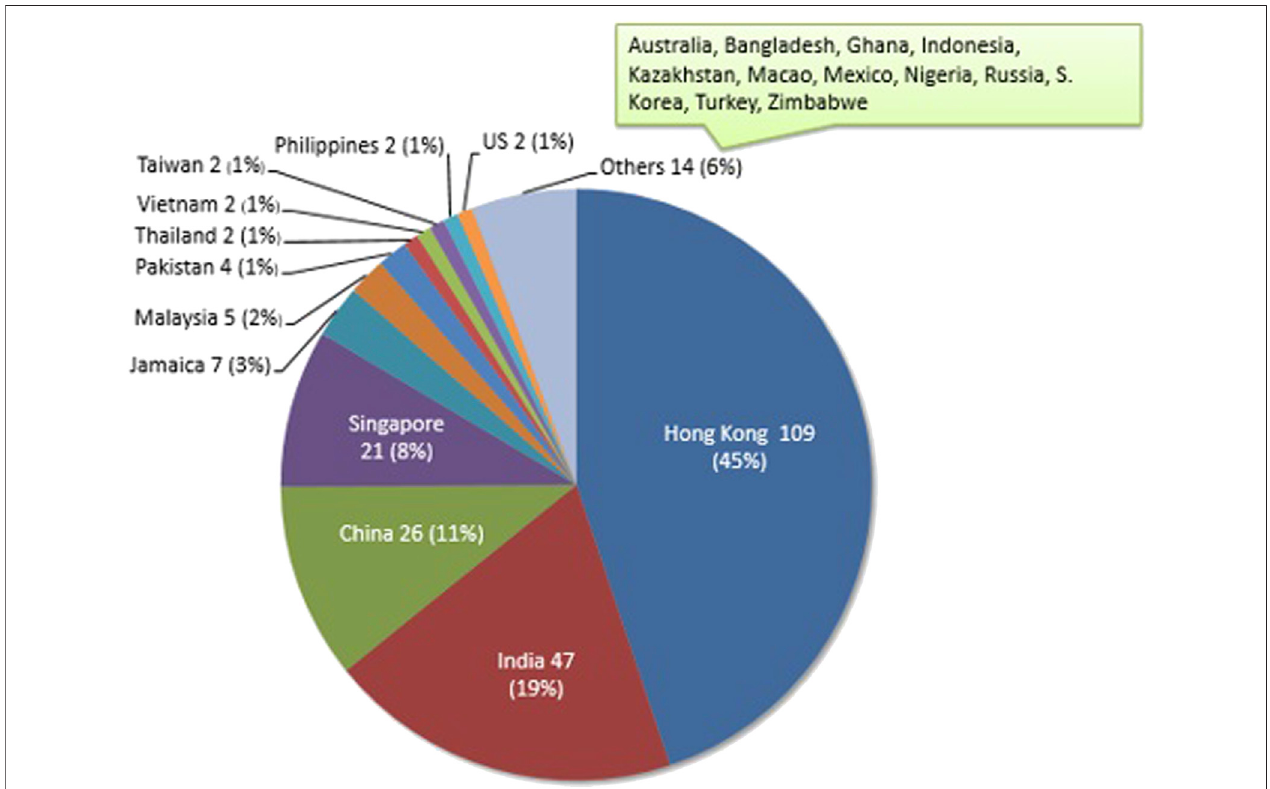
FIGURE 3 | Home region of student participation ( fi rst eTournament) ( N (cid:1) 243).